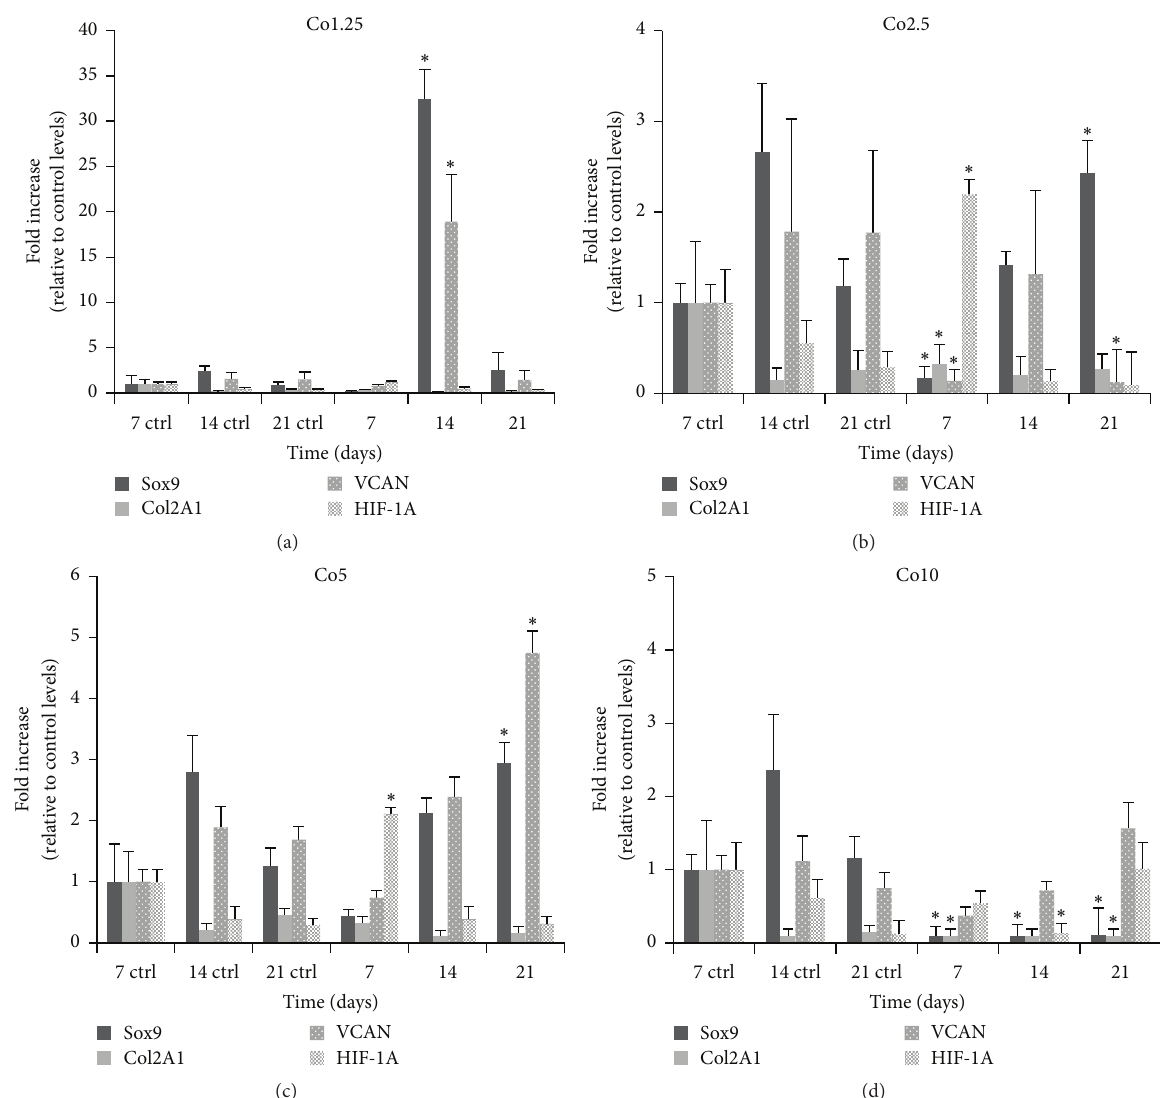
Figure 5: qRT-PCR analysis of hADSCs encapsulated within Ca/Co alginate beads. Expression levels of marker genes were normalized to that of GAPDH and calculated as fold changes relative to expression levels of hADSCs encapsulated within control Ca alginate beads at 7 days. Data are given as means ± the SD ( 𝑛 = 3 independent experiments; ∗ 𝑃 < 0.05 ). VCAN: